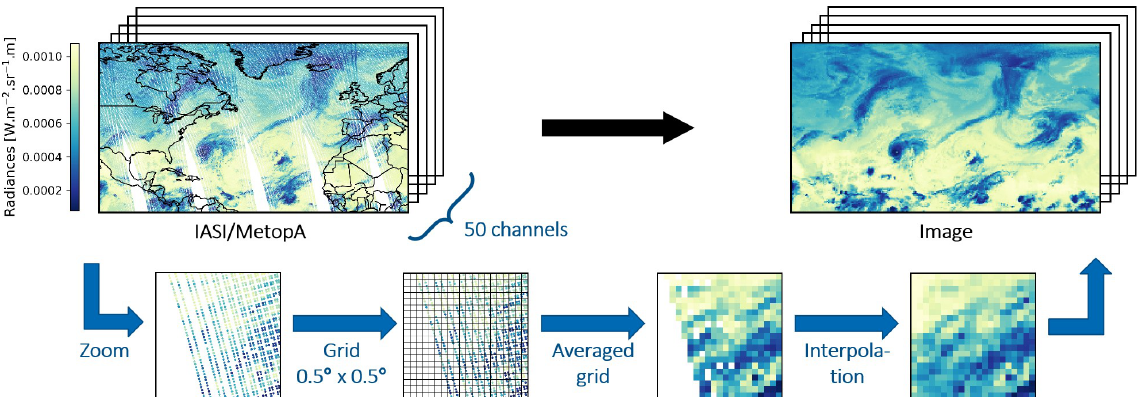
Figure 4. Diagram of the image processing for half a day of IASI observations in a region of high cyclonic activity (North Atlantic Basin). The channel illustrated out of the 50 is the one with wavenumber at 969.75 cm − 1 .